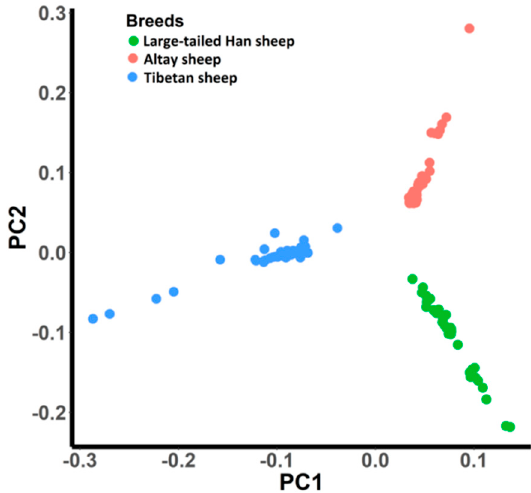
Figure 2. Principal component analysis (PCA) for population structure of three Chinese indigenous sheep breeds with extreme tail types. The first (PC1) and second (PC2) components were plotted.